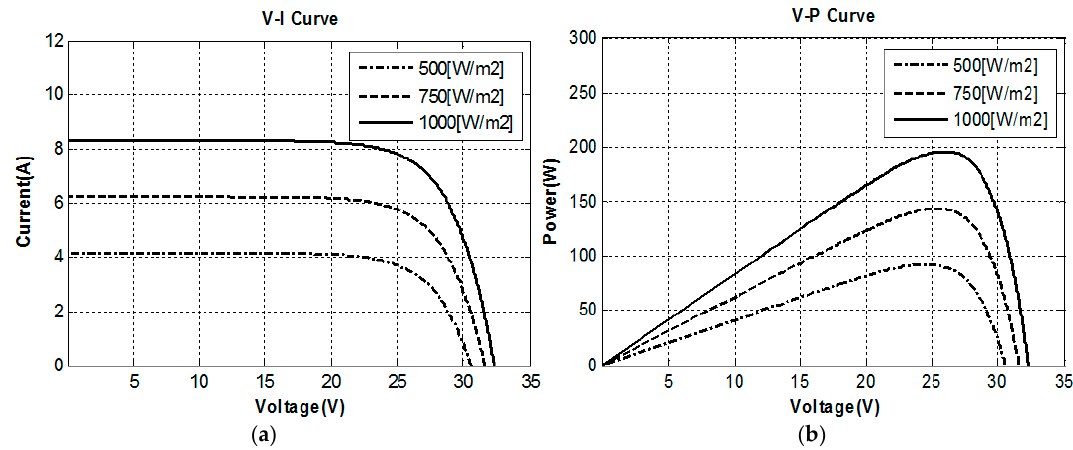
Figure 13. Electrical characteristics of the simulated PV modules under different irradiance conditions. ( a ) V-I curve; ( b ) V-P curve.